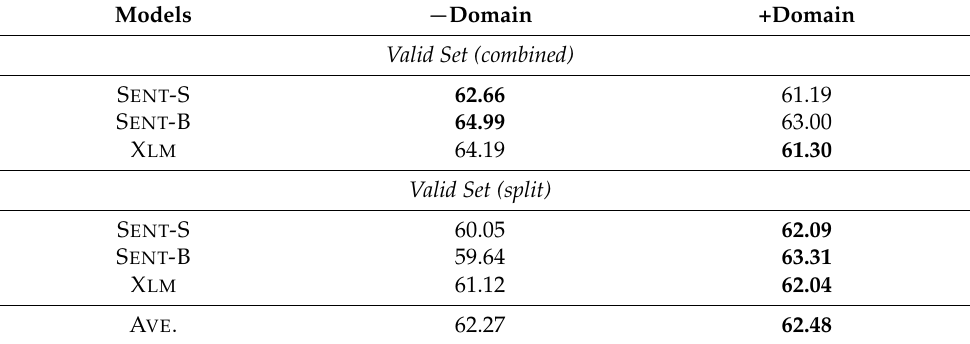
Table 4. Effects of domain adaptation strategy on different De ⇒ En models. The “AVE.” represents averaged score over three models under Split Valid